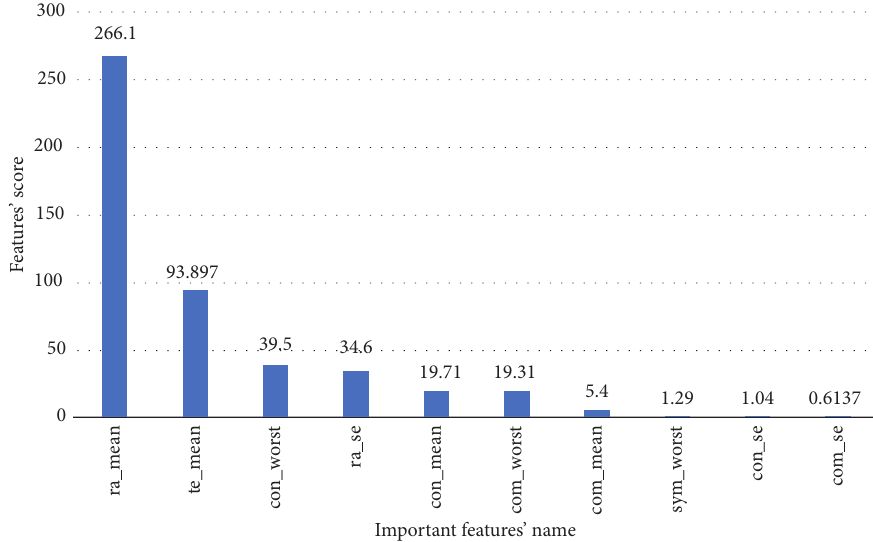
Figure 4: Scores of the selected features by